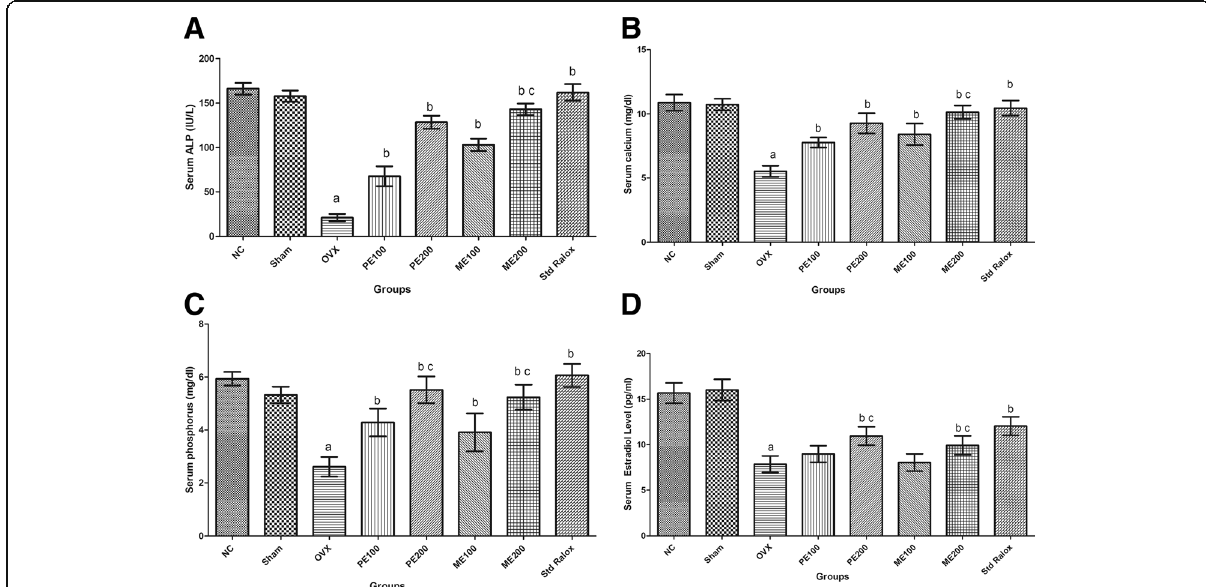
Fig. 5 Effect of plant extracts of B. ceiba on serum biochemical parameters, ( a ): ALP, ( b ): calcium, ( c ): phosphorus, ( d ): Estradiol levels. Results: mean± SD, analyzed by one-way ANOVA followed by Bonferroni ’ s multiple comparison tests; a P <0.05 vs. Sham; b p <0.05 vs. OVX; c p >0.05 vs. Std